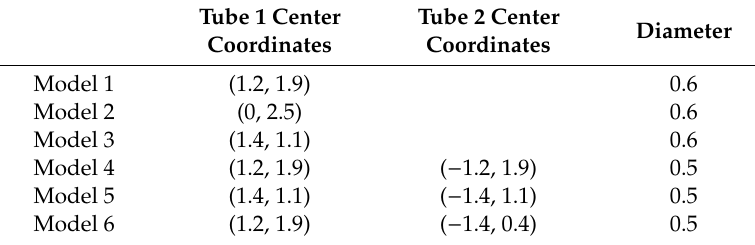
Figure 1. Roadway and ventilation duct parameters and arrangement. Table 2. Pipe position and pipe diameter parameters of each model.